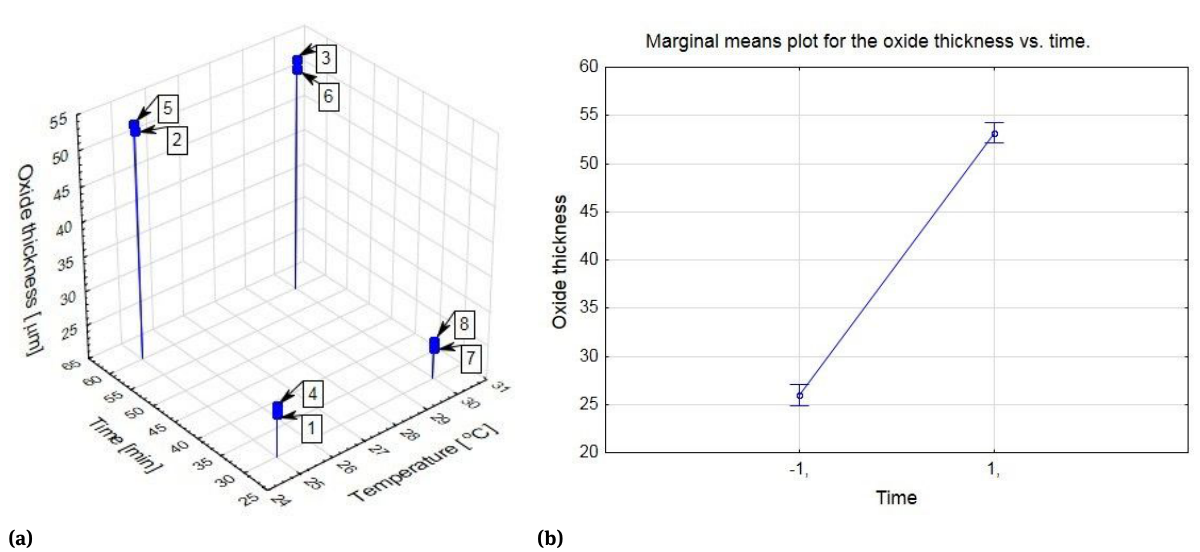
Figure 2: (a) The scatter chart of oxide thickness over time and temperature of anodizing process; (b) Marginal means plot for the oxide thickness vs. time. The confidence intervals are set for 95%